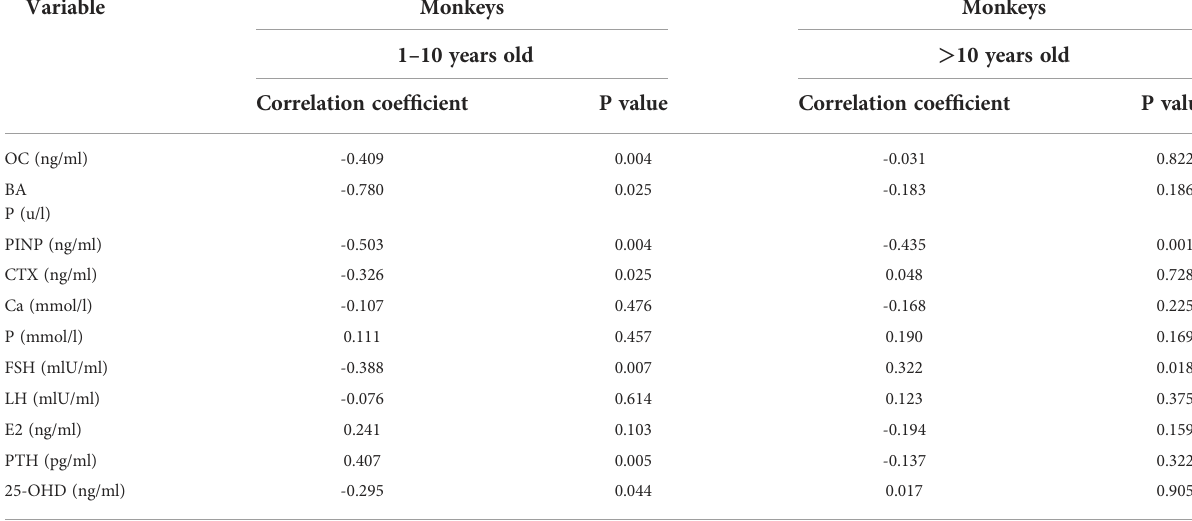
TABLE 3 Correlations between indicators and age in female cynomolgus monkeys.